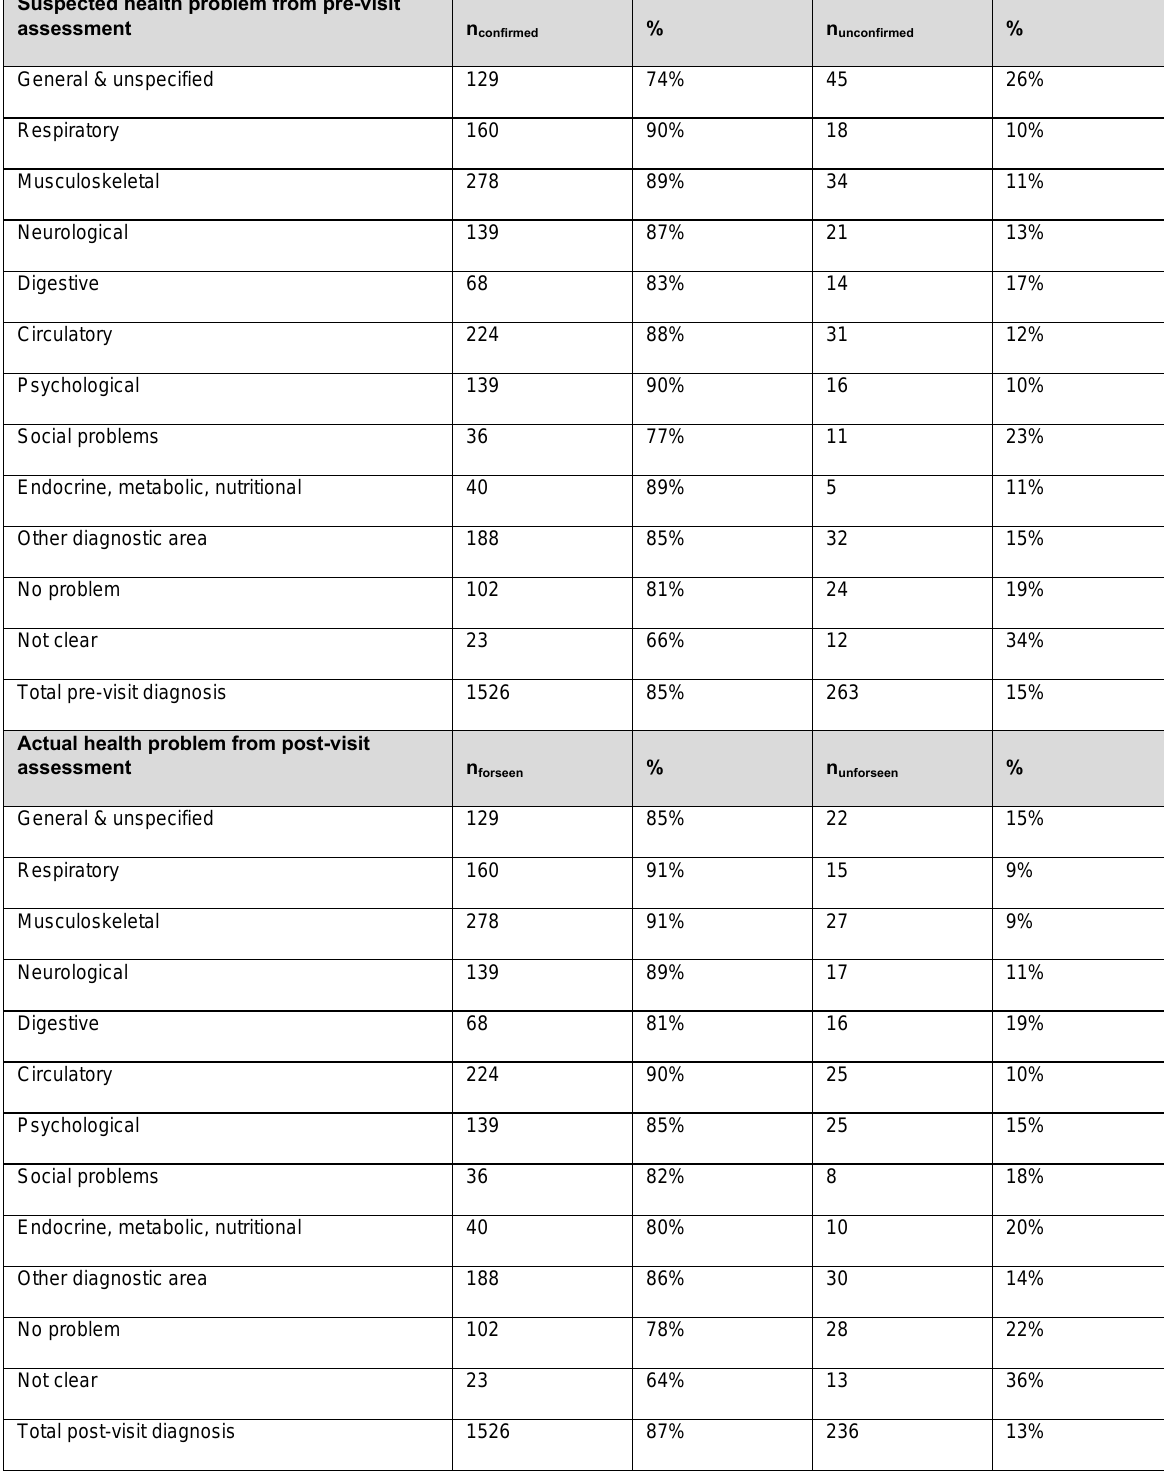
Table S1: Acc uracy of